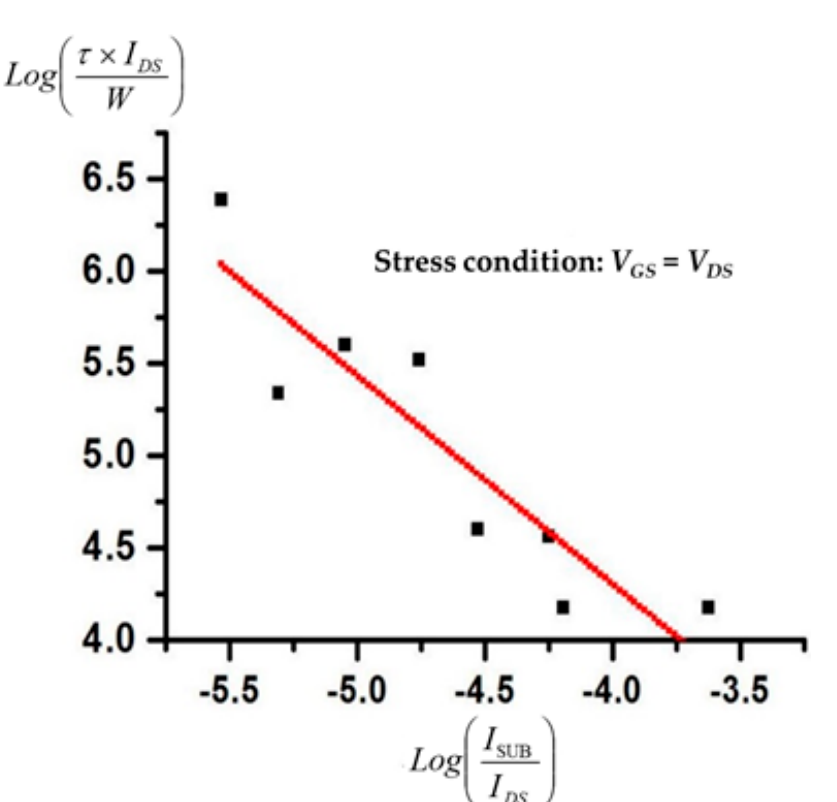
Figure 9. n-MOSFETs lifetime data using the proposed model plotted on log ( τ × I DS / W ) versus I SUB / I DS .